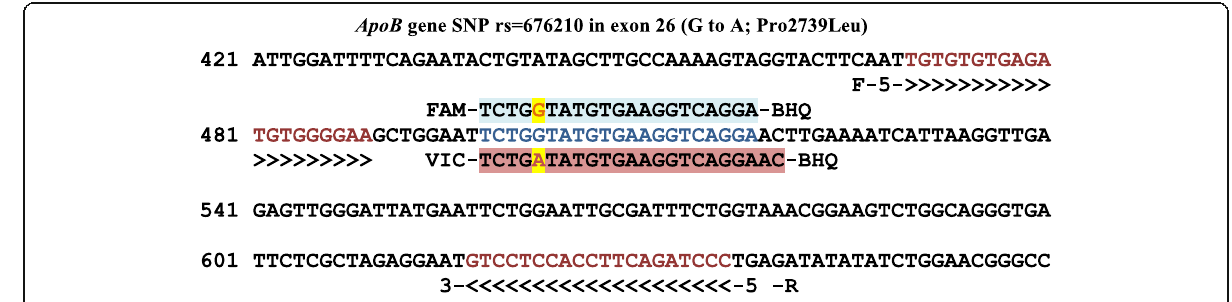
Fig. 1 Matching of the primer and probe sequences of Apo B gene in Exon 26 on the bioinformatic programs/NCBI